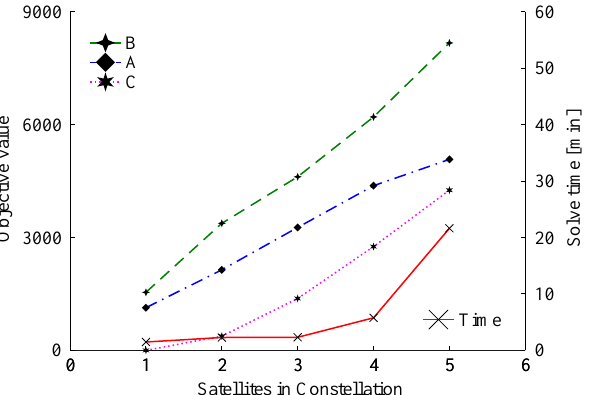
Figure 9. Collective (A), individual (B) and redundancy (C) objective values with the respective solving time for varying sizes of the constellation—from one to five